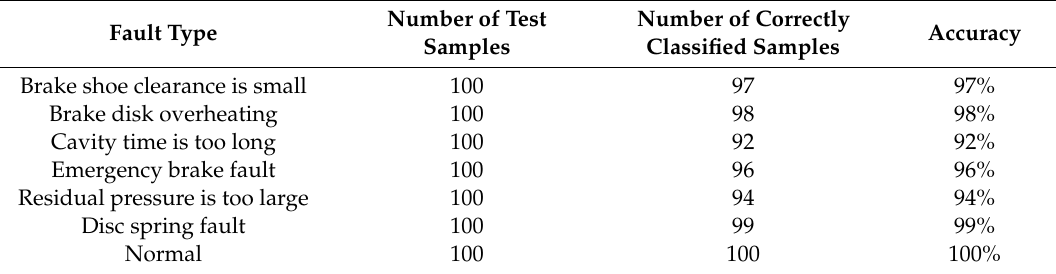
Table 9. Diagnostic rule test